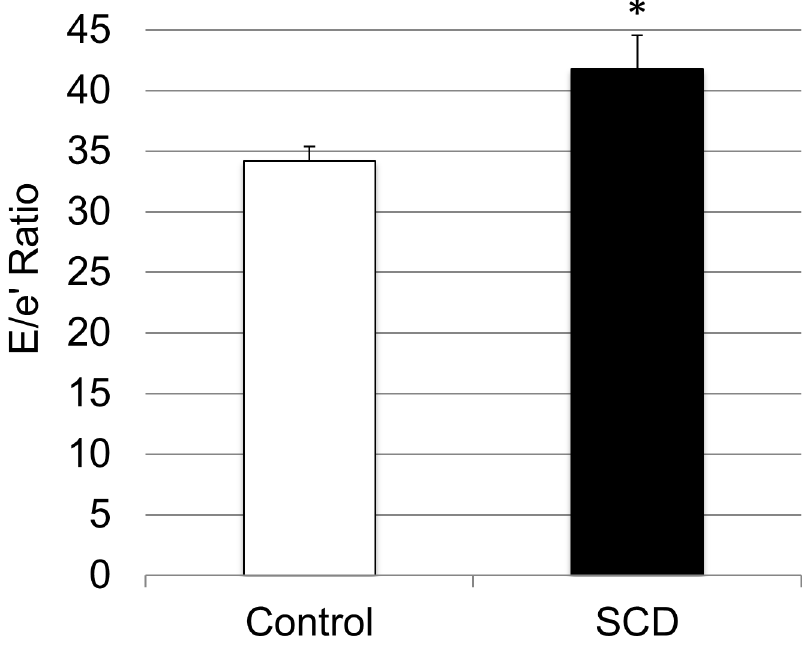
Fig 1. Comparison of E/e 0 ratio between mice with and without sickle cell disease. Error bars denote standard error of the mean. * (cid:2) 0.05.